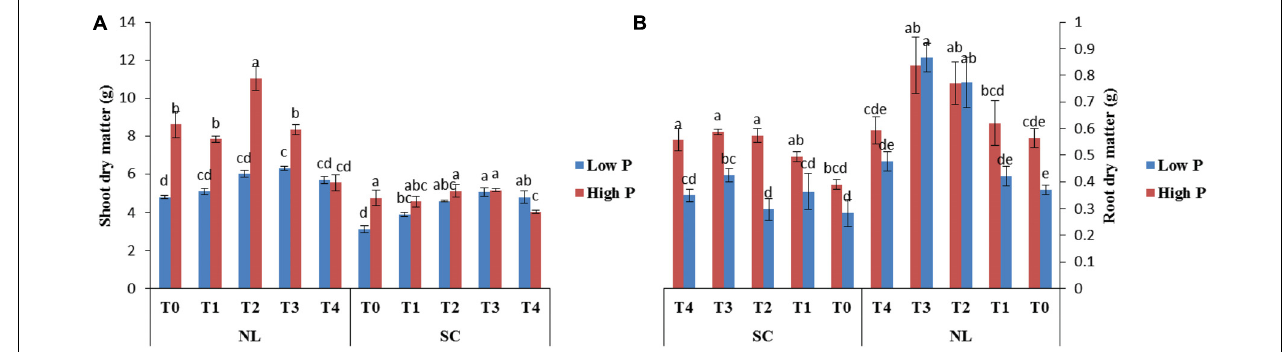
FIGURE 1 | Effect of Ti on (A) shoot dry matter and (B) root dry matter of soybean under NL and SC combined with LP and HP conditions. The bar plots with different lettering show the significant difference among cultivars at probability < 0.05. The error bars are the ± SD values with n =